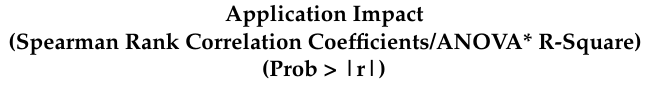
Table 1. Spearman Rank Correlation/ANOVA*—Application Impact.